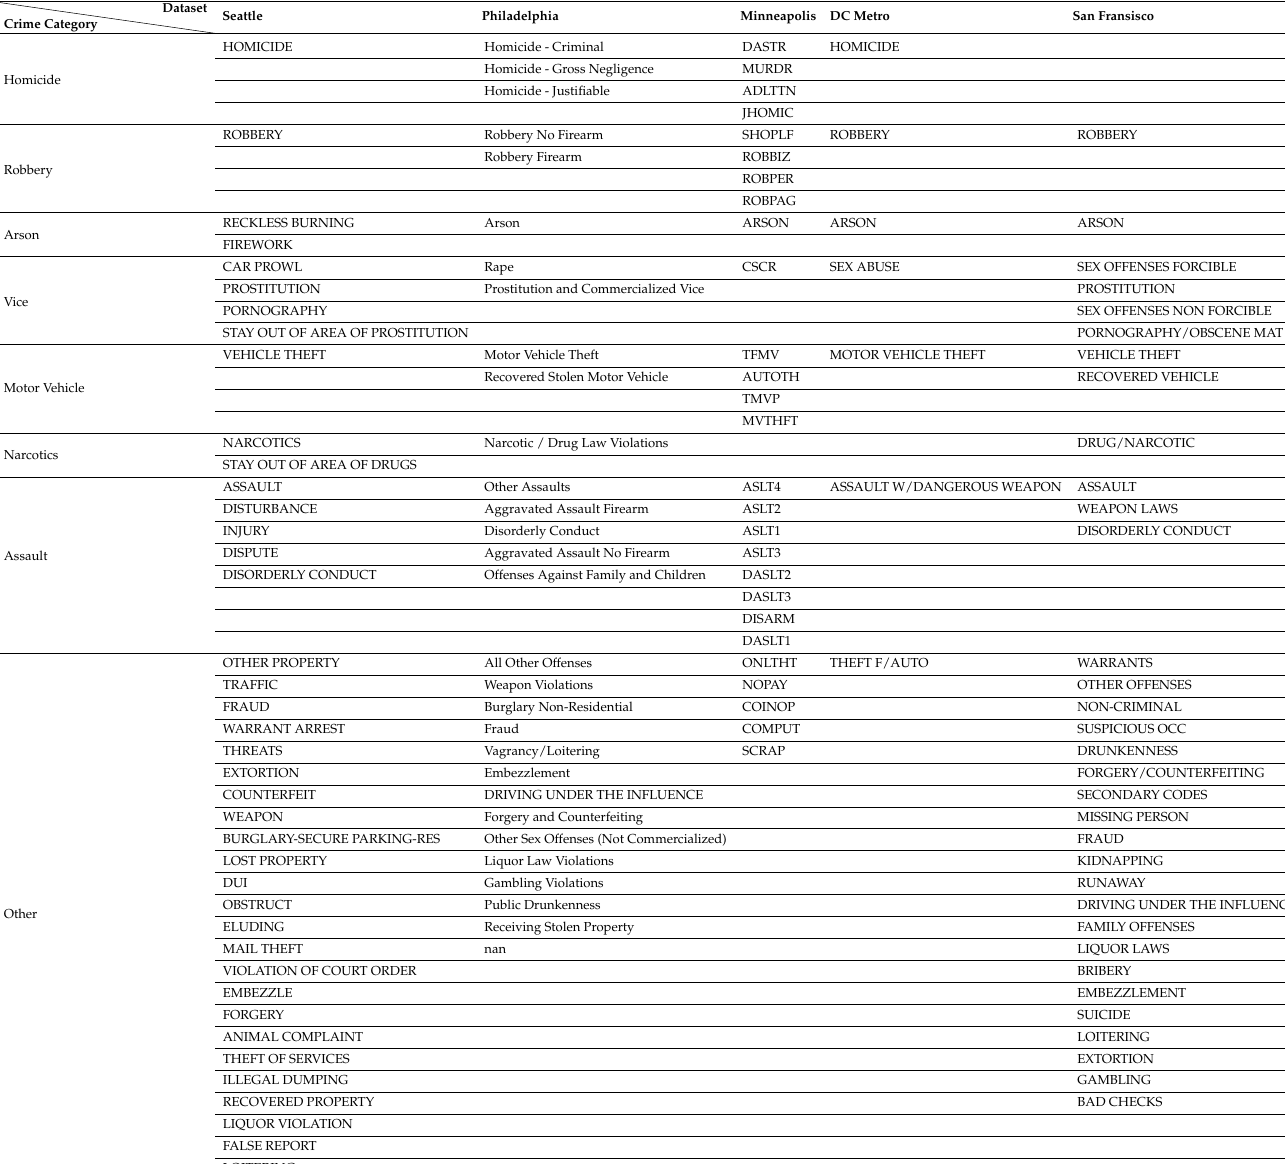
Table A1. Mapping of Crime Categories to the 10 Crime Types for every